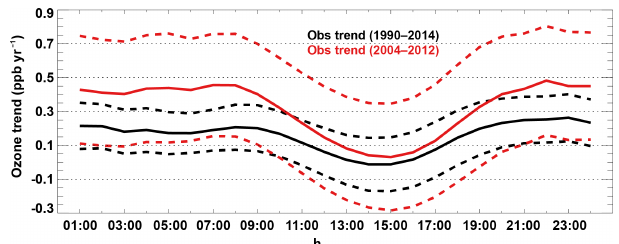
Figure 3. Trends in the observed surface ozone over the US, cal- culated based on data in the selected 124 grid cells. The black line shows the 1990–2014 trend in the US annual mean ozone for each hour of the day (local standard time), the red line depicts the ob- served trend over 2004–2012, and the dashed lines indicate their